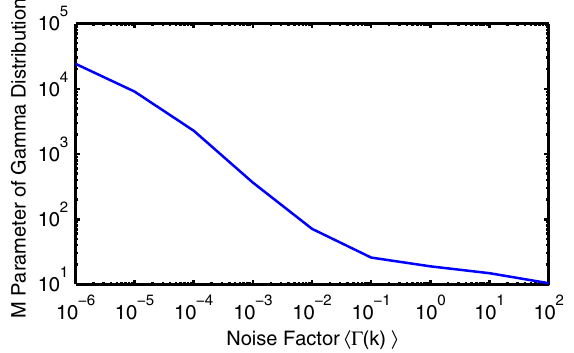
FIG. 6. M parameter as a function of the noise factor. Both axes are in a logarithmic